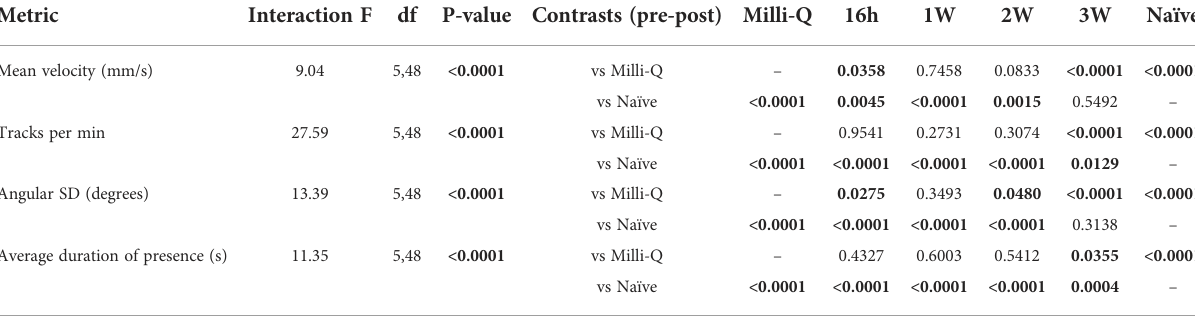
TABLE 1 Two-way ART ANOVA interaction effects, testing changes in each of the behaviour measurements pre vs post-addition of SCW. Metric